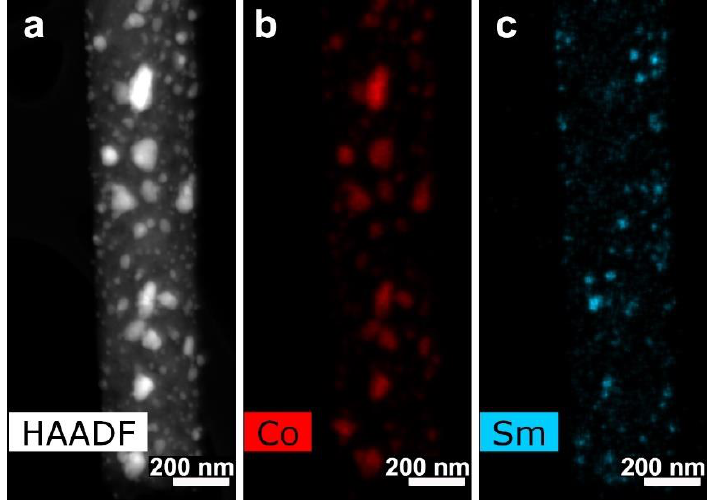
Figure 13. ( a ) HAADF STEM and EDX distribution maps for ( b ) Co and ( c ) Sm for sample 3.